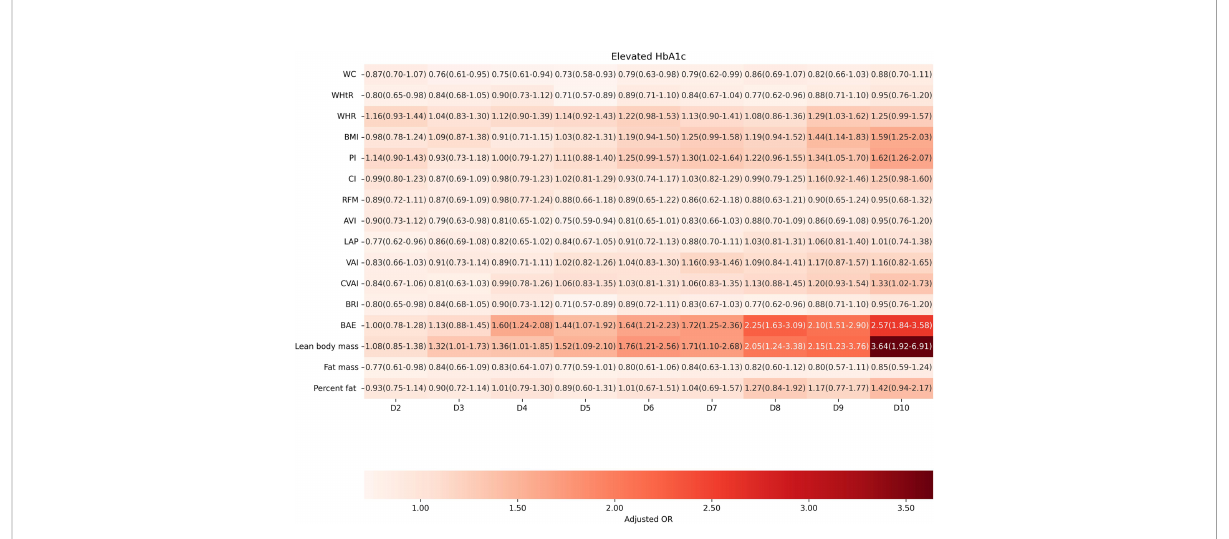
FIGURE 5 The association between deciles of obesity indicators and elevated HbA1c. The fi rst decile (D1) was used as reference. Adjusted for age, gender, education level, equivalent household income, drug history, family history of diabetes, smoking status, drinking status, regular exercise, hypertension, TC, LDL-C, HDL-C, and TG; for lean body mass, fat mass and height were further adjusted; for fat mass, lean body mass and height were further adjusted. WC, waist circumference; WHtR, waist-to-height ratio; WHR, waist-to-hip ratio; BMI, body mass index; PI, ponderal index; CI, conicity index; RFM, relative fat mass; AVI, abdominal volume index; LAP, lipid accumulation product; VAI, visceral adiposity index; CVAI, Chinese visceral adiposity index; BRI, body roundness index; BAE, body adiposity estimator.